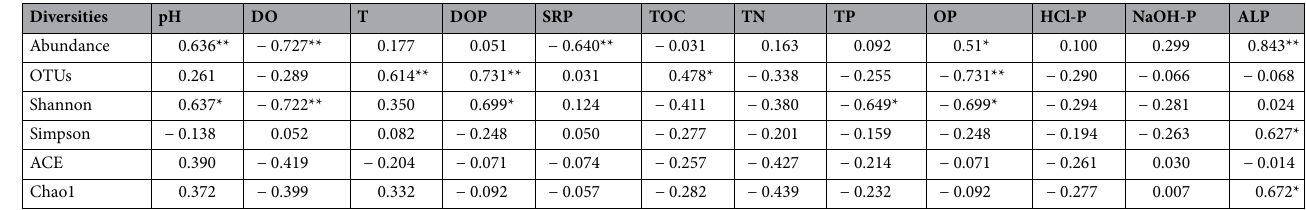
Table 3. Statistical analysis of diversities and abundances of phoD gene with physicochemical parameters. *P < 0.05; **P < 0.01. n = 18.